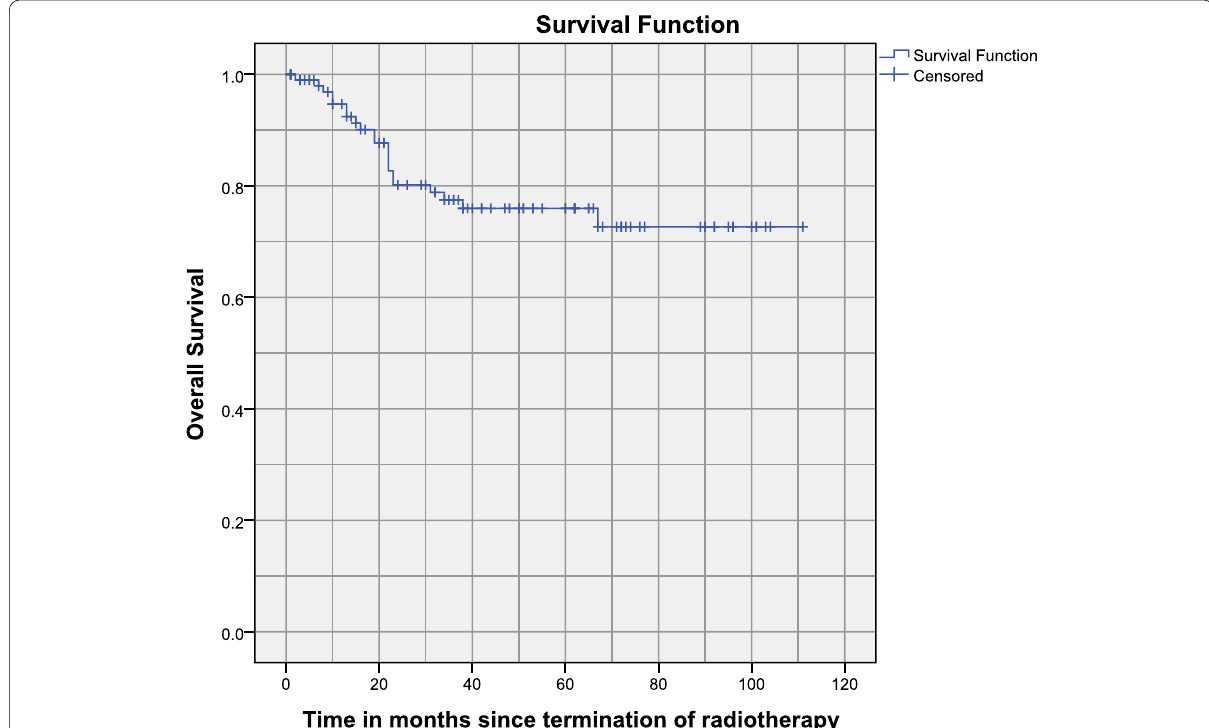
Fig. 1 Kaplan-Meyer survival curve for overall